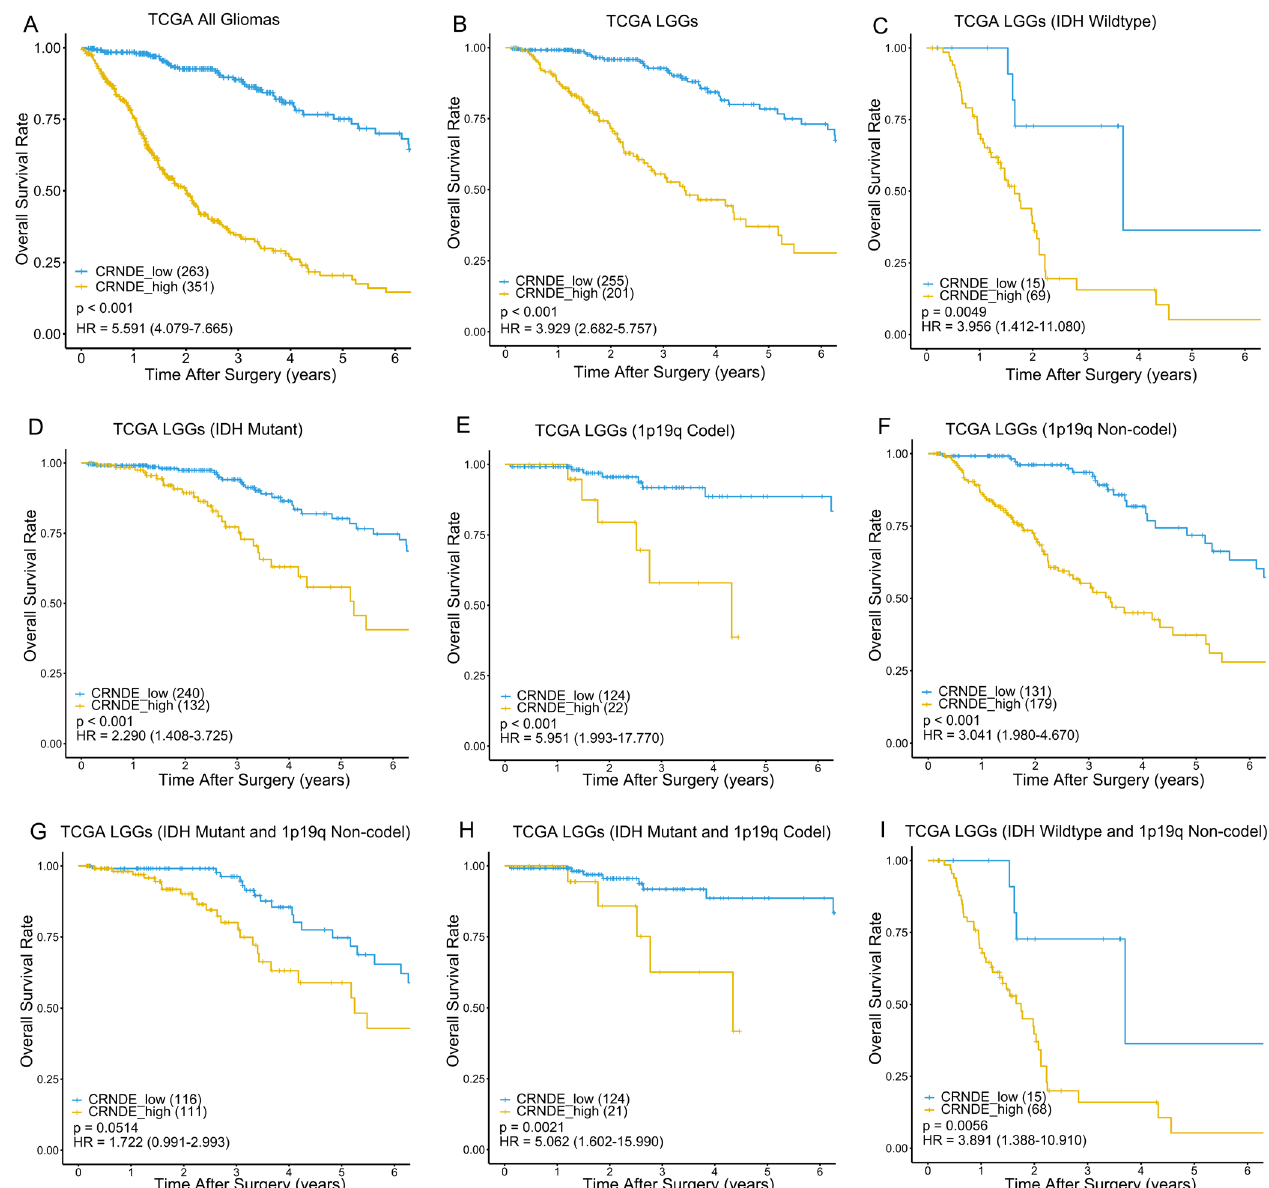
Figure 2. Kaplan–Meier survival curves of the high- and low-expression groups according to IDH and 1p19q status in TCGA dataset. Kaplan–Meier survival analyses were performed on ( A ) 614 glioma patients, ( B ) 456 LGG patients, ( C ) 84 patients with wildtype IDH, ( D ) 372 patients with IDH mutation, ( E ) 146 patients with 1p19q codeletion, ( F ) 310 patients without 1p19q codeletion, ( G ) 227 patients with IDH mutation and without 1p19q codeletion, ( H ) 145 patients with IDH mutation and 1p19q codeletion, and ( I ) 83 patients with wildtype IDH and without 1p19q codeletion.